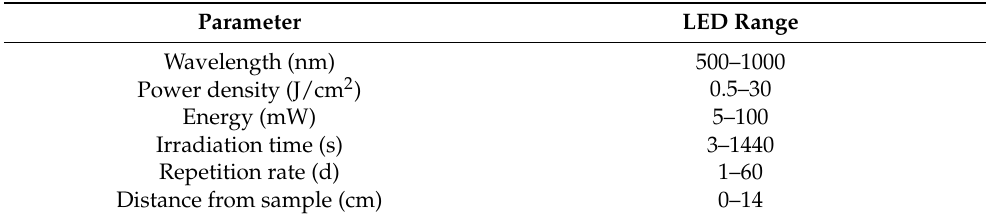
Table 1. Dosimetry parameters of LED device observed in the literature.